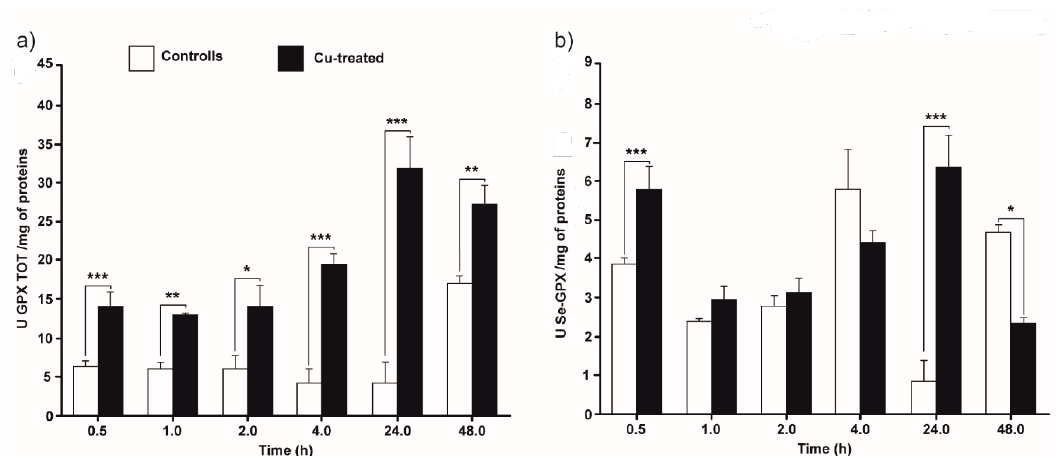
Figure 5. Total GPx ( a ) and selenium-dependent GPx ( b ) activities in control and Cu-treatment conditions. T. thermophila cells harvested at 0.5, 1, 2, 4, 24 and 48 h. The results are reported as mean of three independent experiments ± SD. Statistical differences between the two experimental groups are reported as follows: (*) p < 0.05, (**) p < 0.005 and (***) p < 0.001.